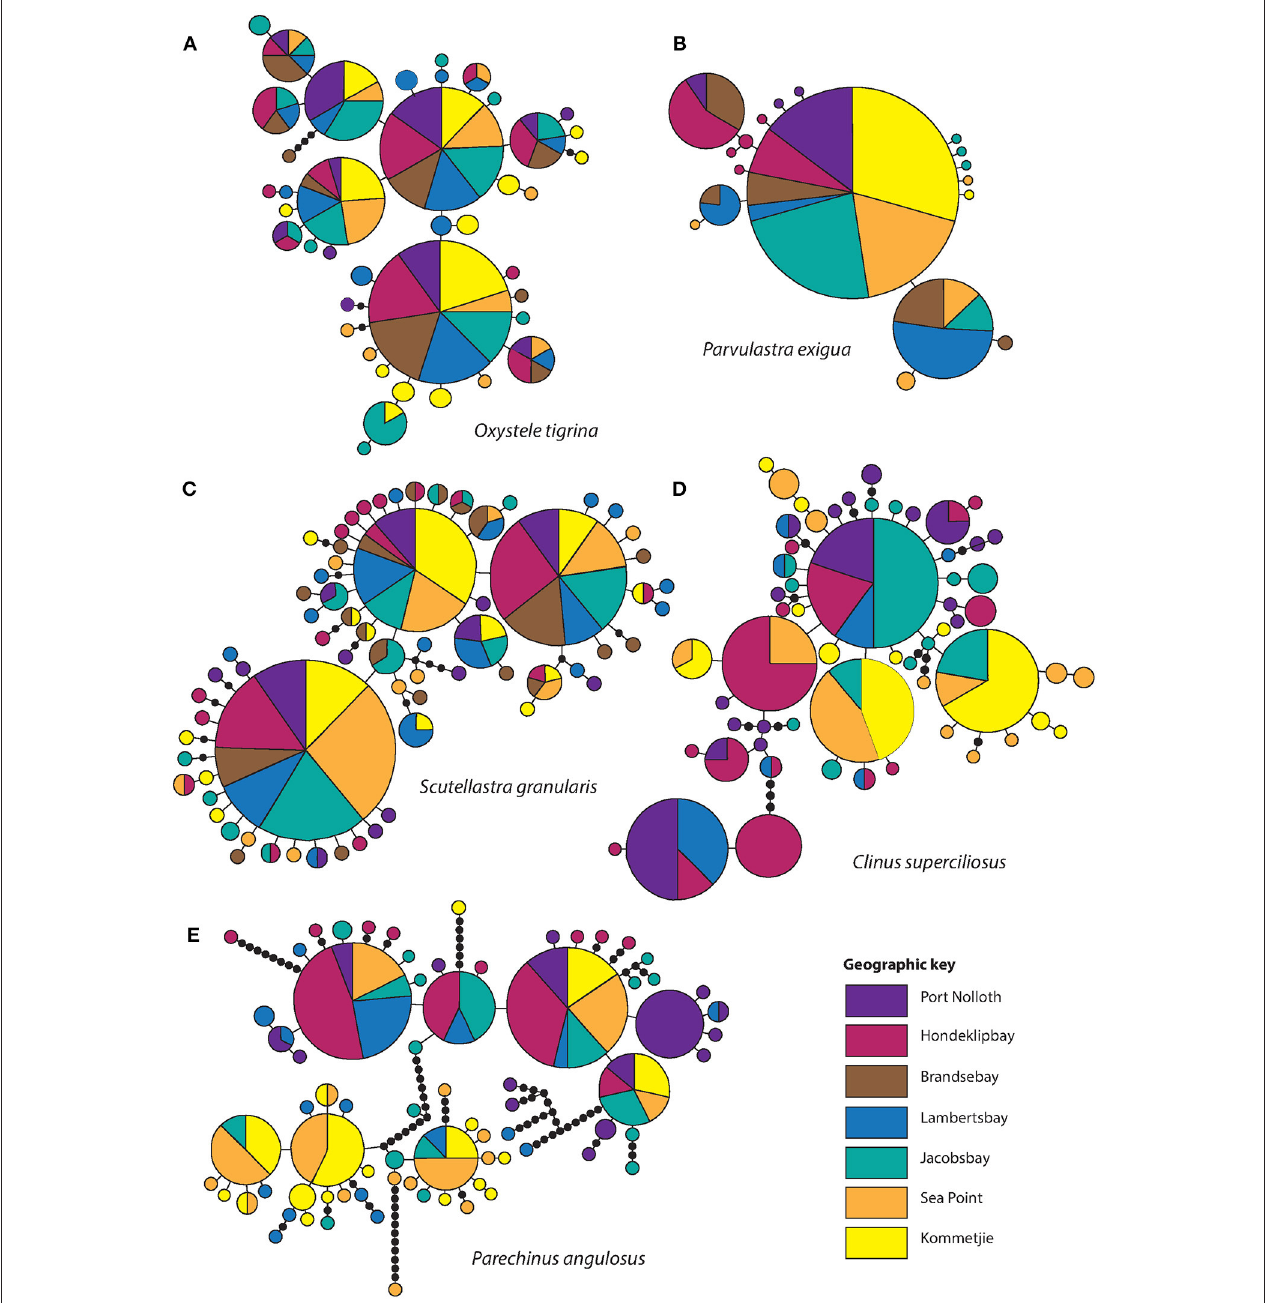
FIGURE 2 | Haplotype networks. The size of the circles is proportional to the frequency of each haplotype. Each line represents one mutational step. Black dots mark missing steps. (A) O. tigrina , (B) P. exigua , (C) S. granularis , (D) C. superciliosus , and (E) P. angulosus .